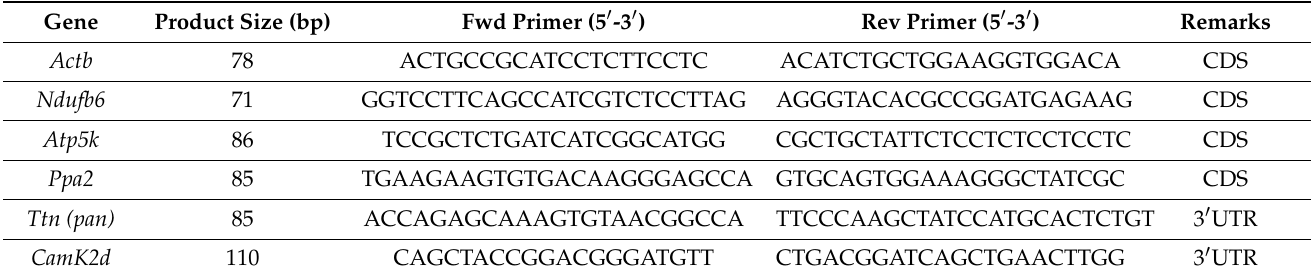
Table 1. Used primers for validation of distinct results obtained from genome-wide expression analysis by